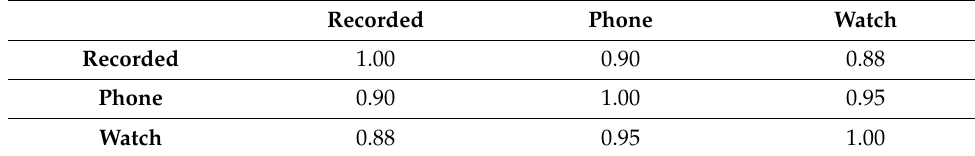
Watch Table 3. Pairwise correlation for the first experimental series. Table 4 shows the results from the second experimental series. The “GT3X” column represents the ground truth for bout duration comparisons. The average difference against the GT3X results falls into the range of [2.22%, 5.27%]. Hence, our proposed approach achieved very good accuracy on the data from all six phones. The averaged standard deviation is 2.03 s in an averaged bout duration of 53.56 s. In addition, we evaluated the pairwise correlations among all the devices. As shown in Table 5, bout durations based on different devices are highly